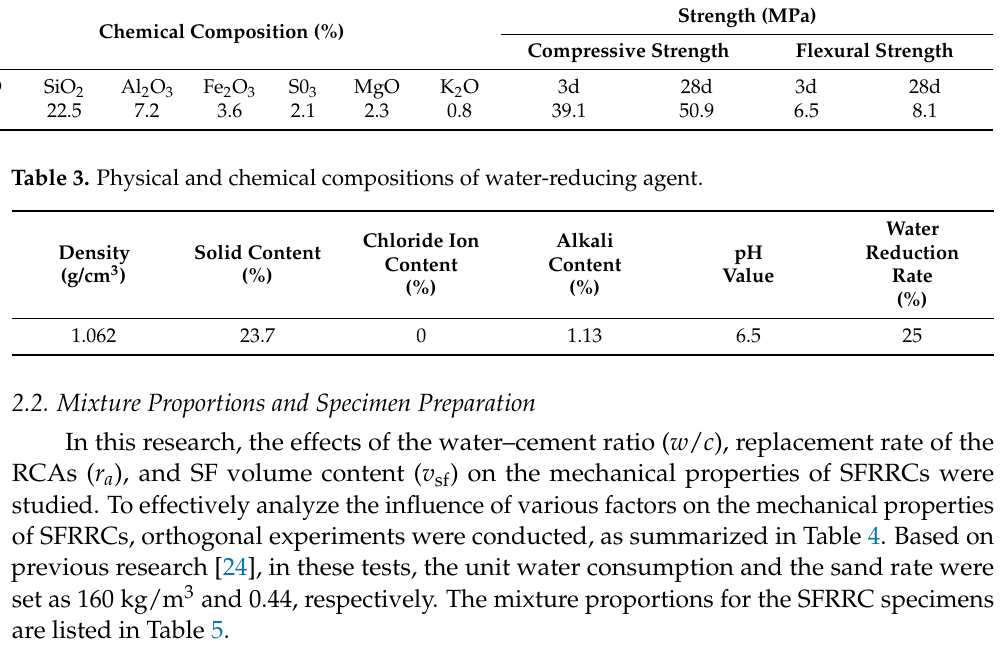
Table 4. Orthogonal test factors and levels of SFRC.